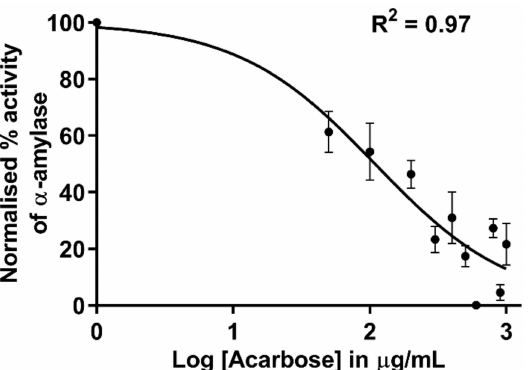
Figure 4. Dose- response curve of inhibition of α -amylase by acarbose. Values are represented as means ± SD ( n = 3).